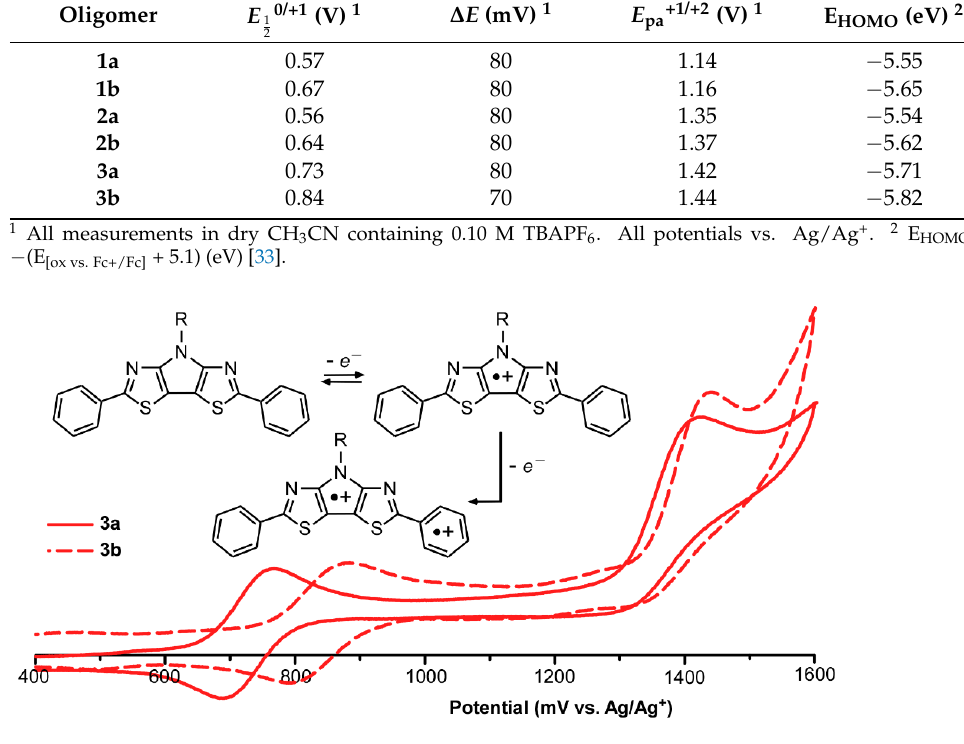
Figure 6. Cyclic voltammograms of the phenyl-capped PBTz oligomers 3a and 3b .